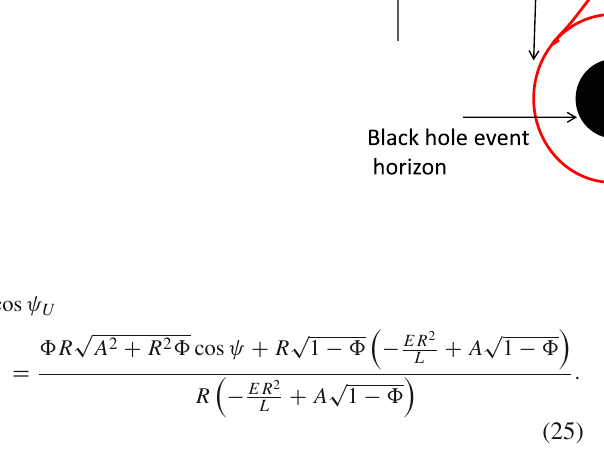
Fig. 1 Black hole shadow relative to the cosmological comoving observer. δ is the observer’s position vector and d represent the vector tangent to the photon path. U α is the comoving observer velocity. The static observer measures ψ